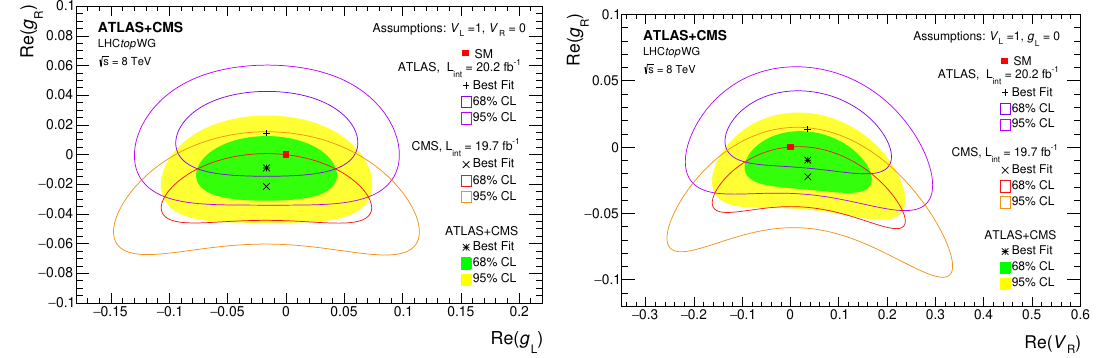
Figure 3 . Allowed regions for the tWb anomalous (left) left- and right-handed tensor couplings, and (right) right-handed vector and tensor coupling. The limits are obtained from the ATLAS, CMS, and the combined measurements of the W boson polarization fractions at 68 and 95% CL. The limits from CMS are obtained using the pre-combined result of all CMS input measurements. The anomalous couplings are assumed to be real.